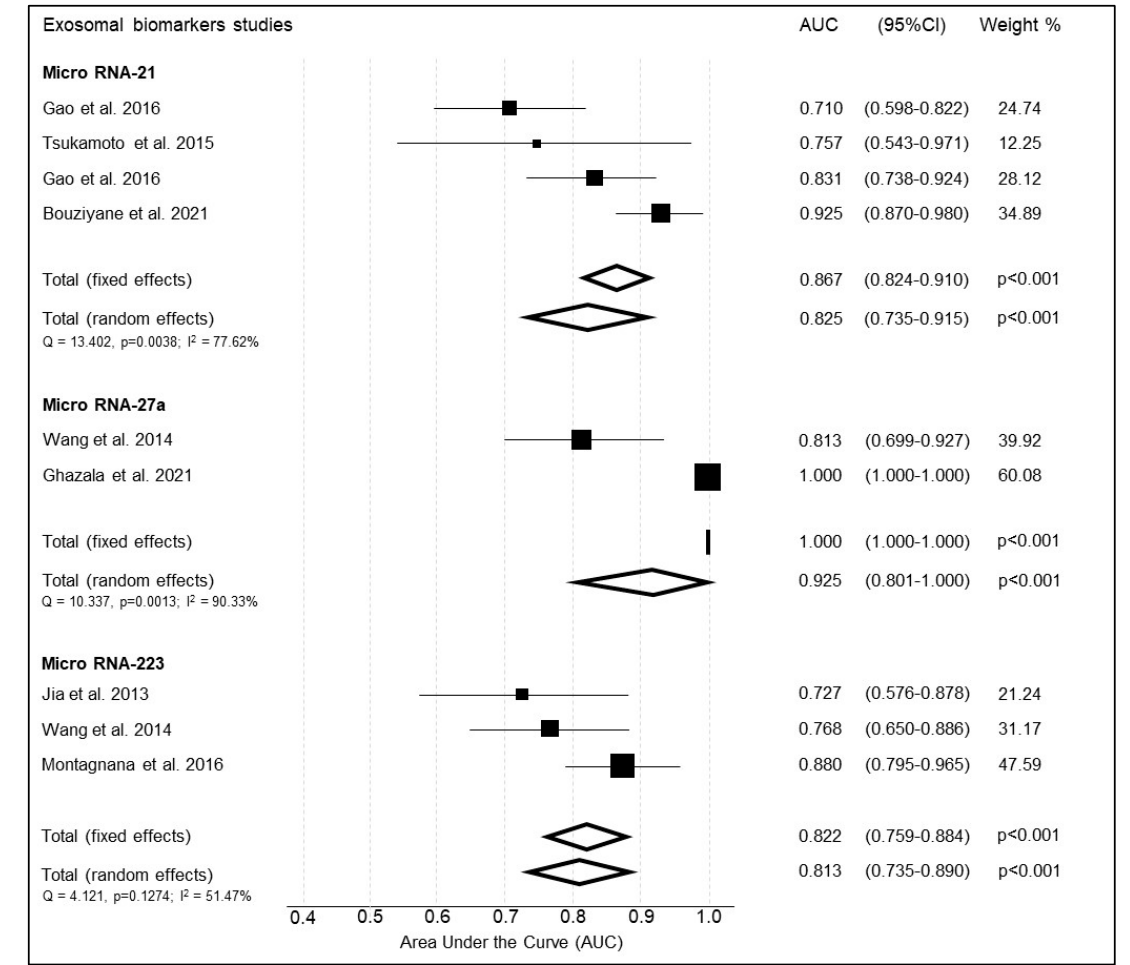
Figure 5. Summary of the diagnostic accuracy of micro-RNAs included in the meta-analysis.